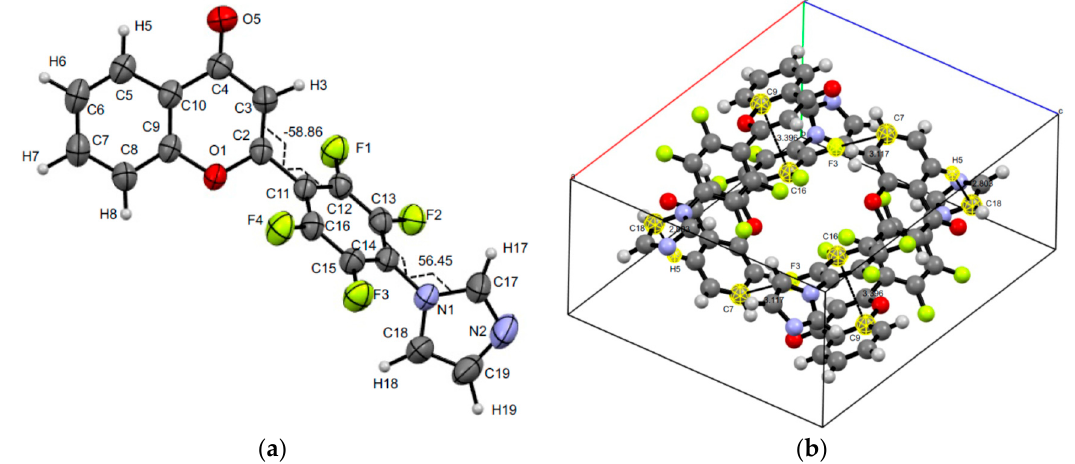
Figure 3. Molecular structure and selected torsions ( a ), and unit cell ( b ) of compound 8 with atoms represented as thermal ellipsoids of thermal vibrations with a 50% probability.